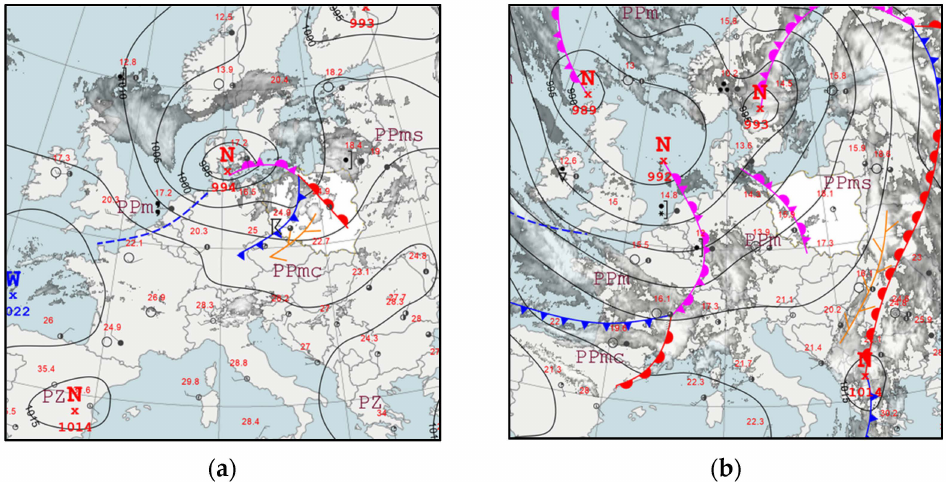
Figure 4. Synoptic maps from IMGW-PIB for the situations of: ( a ) 26 August 2020; and ( b ) 6 October 2020 (occluded